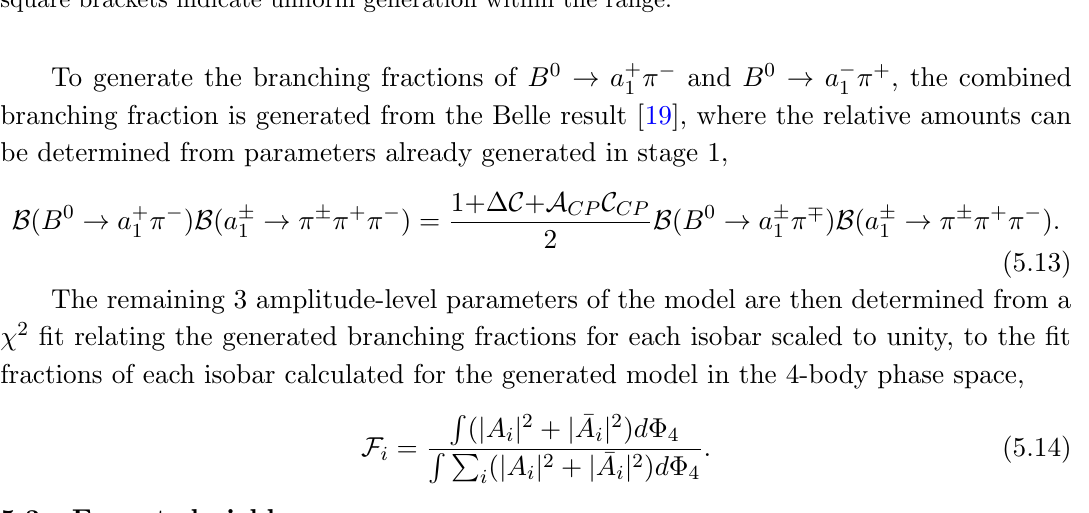
Table 2 . Stage 2 parameters. Uncertainties indicate the parameter was Gaussian distributed while square brackets indicate uniform generation within the